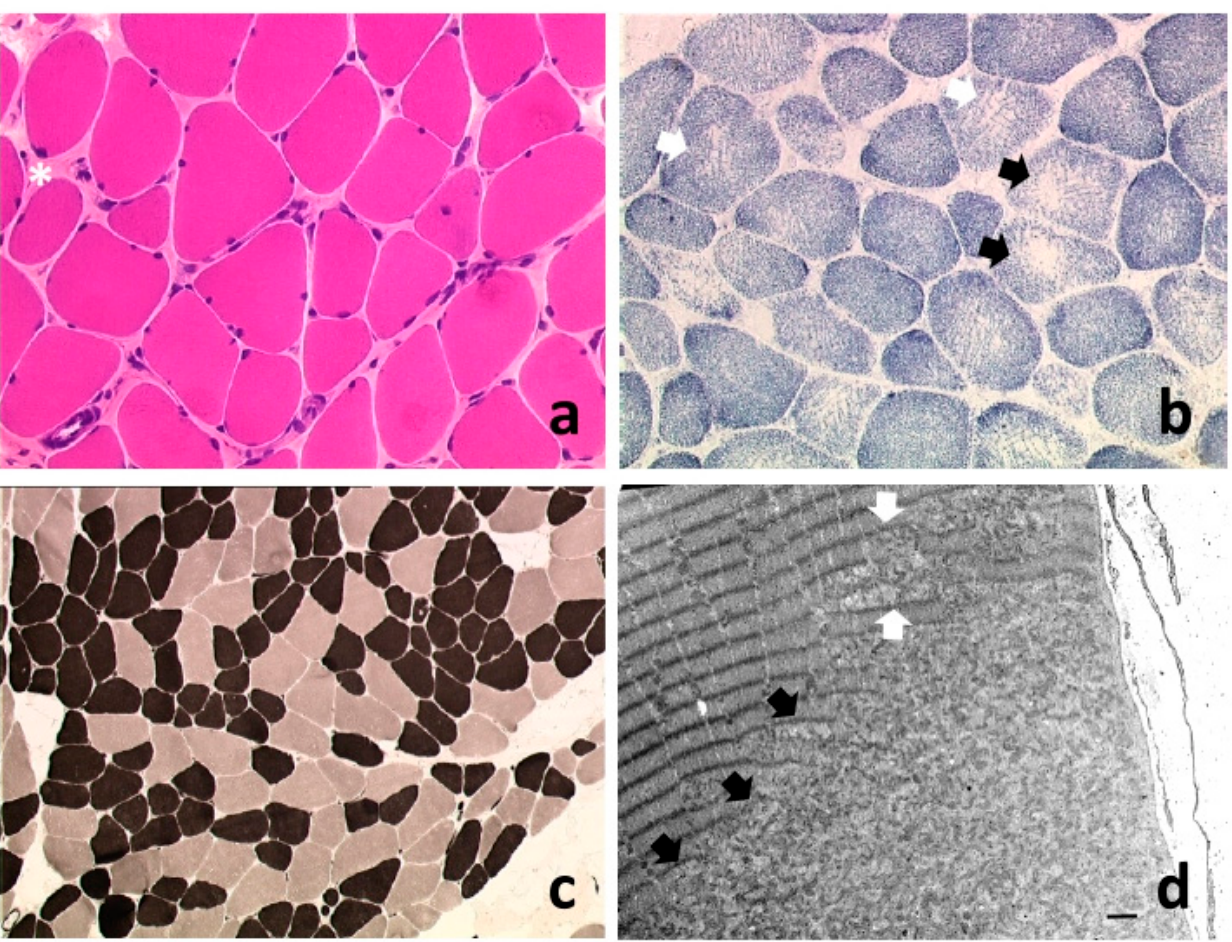
Figure 1. Main histopathological findings in SEPN1-RM. Transversal sections of frozen muscle samples (a–b 20 × , c 10 × ); longitudinal electron microscopy section (d, bar = 2 µ m). ( a ) Variability of muscle fiber diameter, with some rounded, smaller fibers surrounded by increased endomysial connective tissue (asterisk), while mild endomysial fibrosis is frequent, necrotic or regenerating fibers are rarely observed. ( b ) SDH showing fibers with cores (rounded areas devoid of oxidative (mitochondrial) activity, black arrows) or with uneven oxidative staining (white arrows). ( c ) Type 1 fiber predominance and hypotrophy: oxidative fibers (dark) are more abundant and smaller in diameter compared to type 2 glycolitic fibers (light colour). ( d ) Small (white arrows) and longer (black arrows) minicores, contrasting with normally organized sarcomeres and SR/mitochondrial complexes in adjacent areas of the muscle fiber (top left). Minicores are areas of mitochondria depletion and sarcomere disorganization which span a variable but limited number of sarcomeres along the fiber longitudinal axis. Hematoxylin–eosin (H&E) ( a ), SDH ( b ), Myosin ATPase pH 4.65 ( c